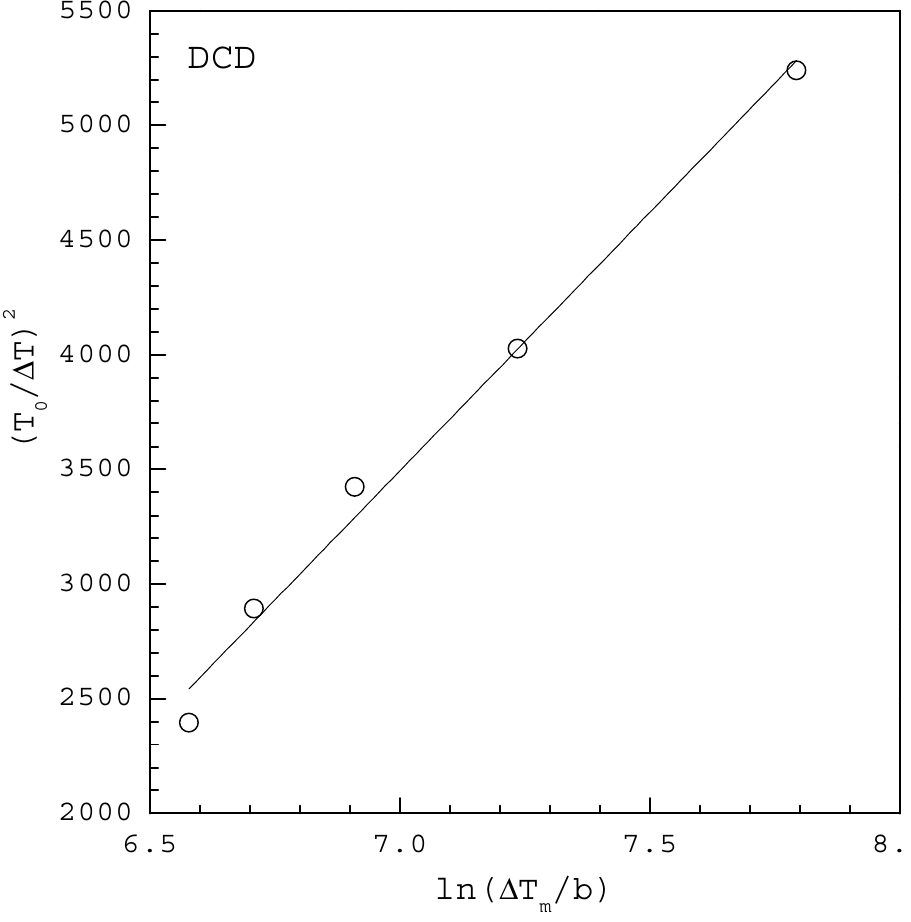
Figure 4. The MSZW data fitted to the linearized Equation (11) for DCD in 100 mL water saturated at T 0 = 293.15 K, where ∆ T m for each b is extracted at 50% of fraction detected nucleation events from the cumulative distributions of the MSZW data obtained by Si et al. [17].